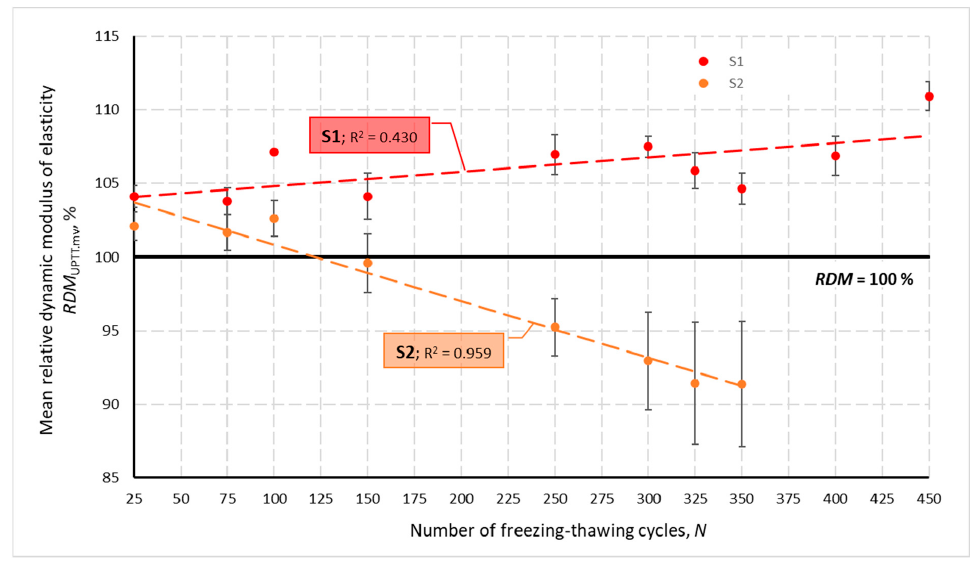
Figure 14. Mean relative dynamic modulus of elasticity for S1 and S2 concretes after N cycles of freezing and thawing. A statistical test was used to conclude the influence of individual admixtures. Calcu- lations associated with a Student’s t -Test determined whether two samples are likely to have come from the same two underlying populations that have the same mean. In the case of concretes S1 and S2, the statistical test results showed that the compressive strength after 28 and 128 days of curing and the strength and RDM UPTT after 300 cycles of frost resistance test come from populations with different mean values. This proves that the influence of SP1 and SP2 superplasticizers on the parameters mentioned above is signifi- cant.